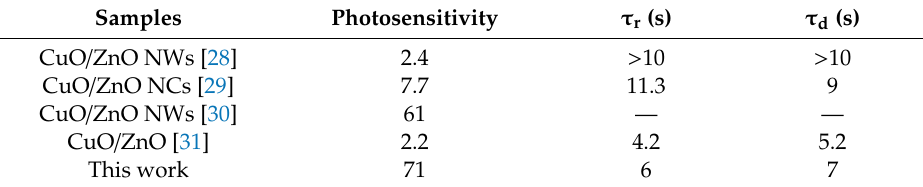
Table 2. The device performance of our device and other CuO / ZnO UV photodetectors.